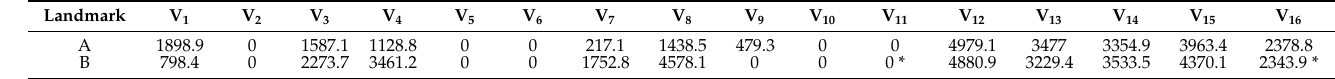
Table 1. Visible area of landmarks from each viewpoint.